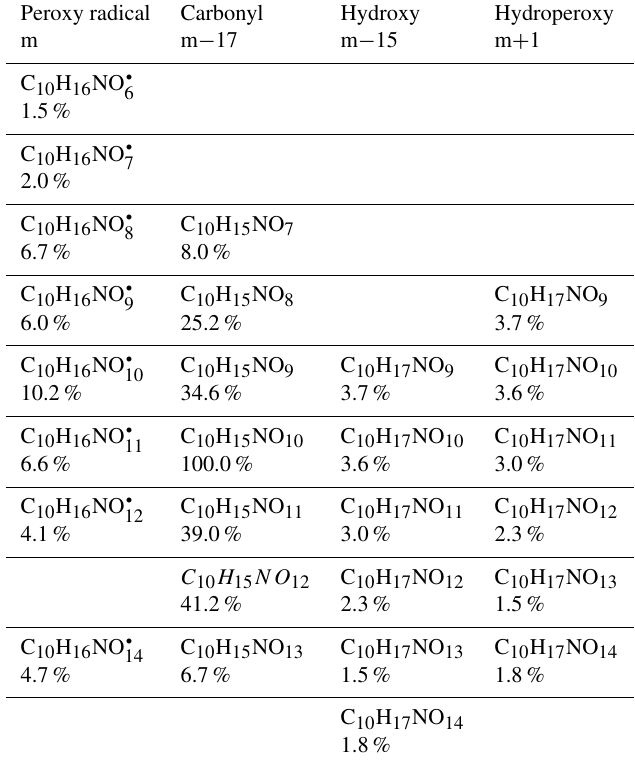
(cid:113) Table 1. Observed C 10 H 16 NO x radicals (m) and their termination products, including carbonyl compounds (m (m − 15), and hydroperoxy compounds (m + 1). Their concentrations during period P1a are normalized to that of C 10 H 15 NO 10 , which had the highest concentration among the families of 1N-C 10 monomers. Their relative signal intensities during the P1a period are shown in the second line of each cell. Peroxy radical